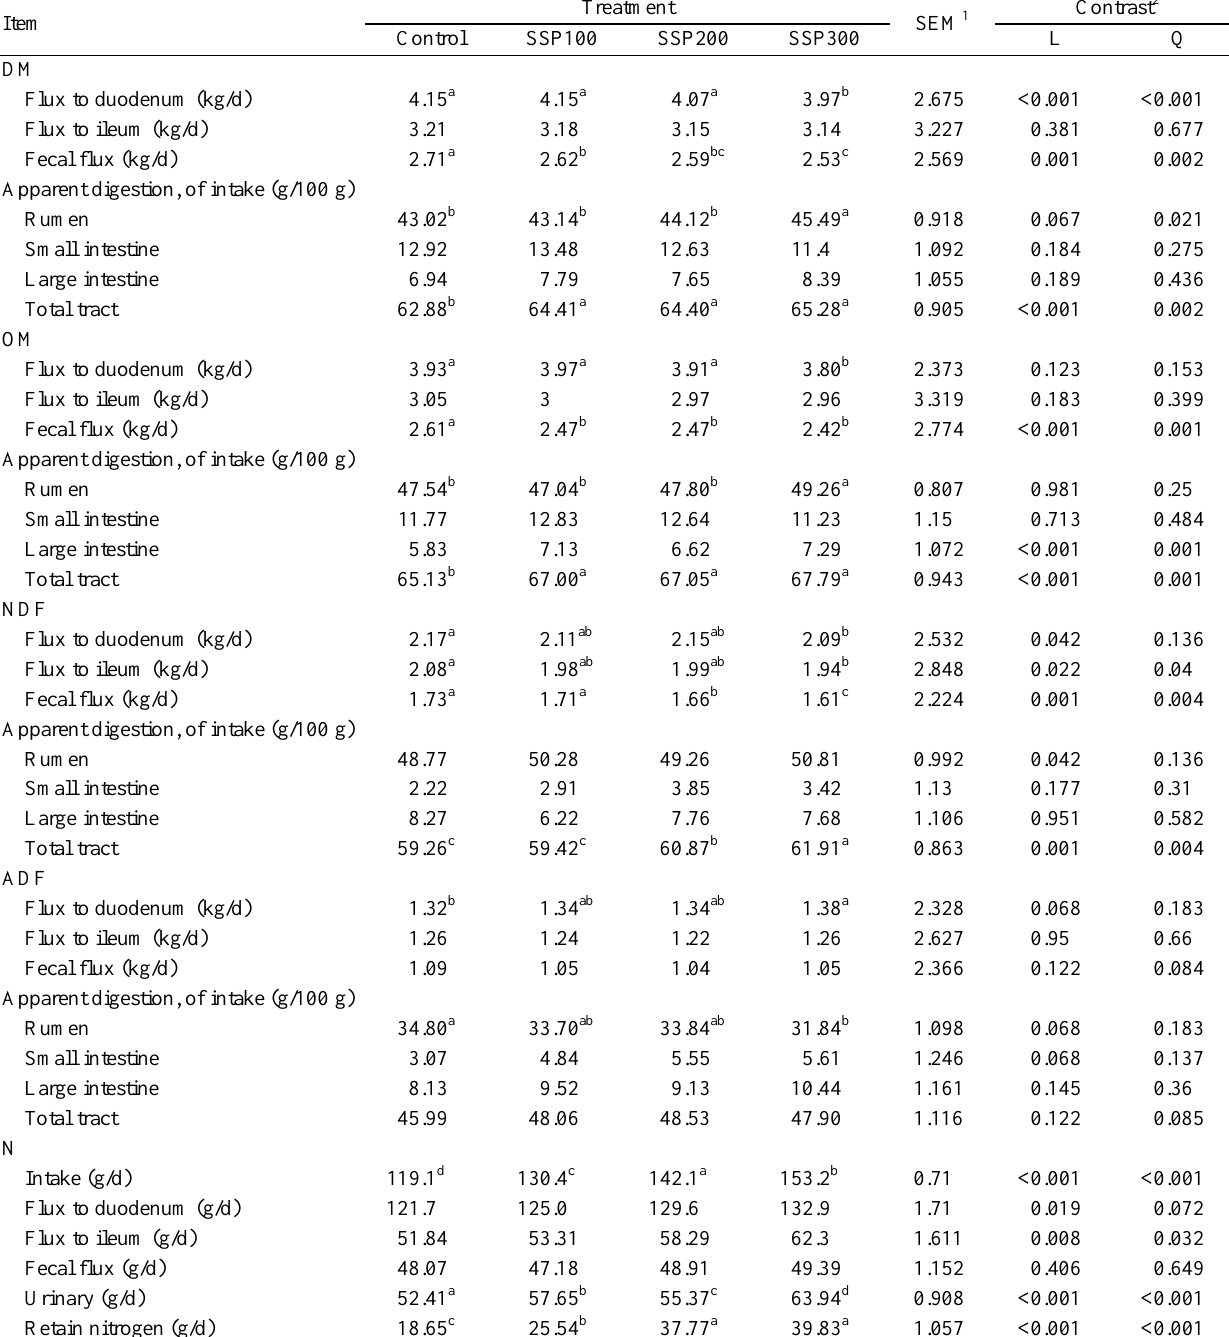
Table 5. Effects of soybean small peptide (SSP) infusion into rumen at the rates of 0 (Control), 100 (SSP100), 200 (SSP200) and 300 (SSP300) g/d on digestion of nutrient at different digestive sites of Luxi Yellow cattle (n =